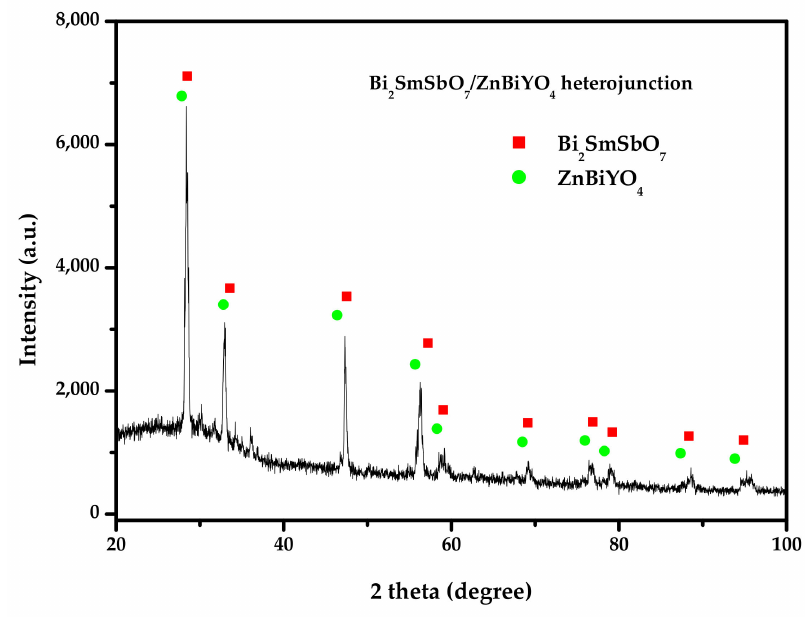
Figure 3. The X-ray diffraction spectrum of Bi 2 SmSbO 7 /ZnBiYO 4 heterojunction.